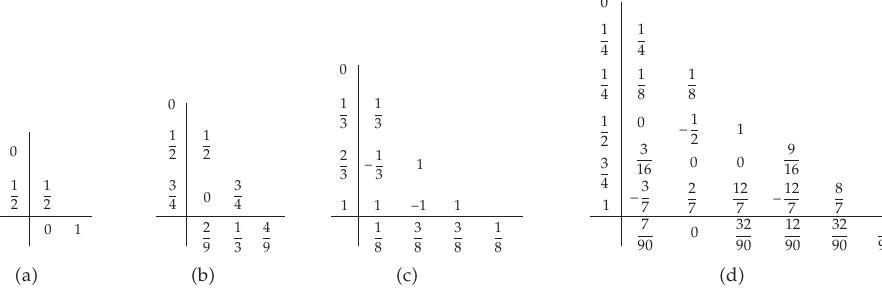
Table 5: RK parameters in Butcher’s notation (cid:8) 15 (cid:9) : (cid:4) a (cid:5) RK2, (cid:4) b (cid:5) RK3, (cid:4) c (cid:5) RK4, and (cid:4) d (cid:5)